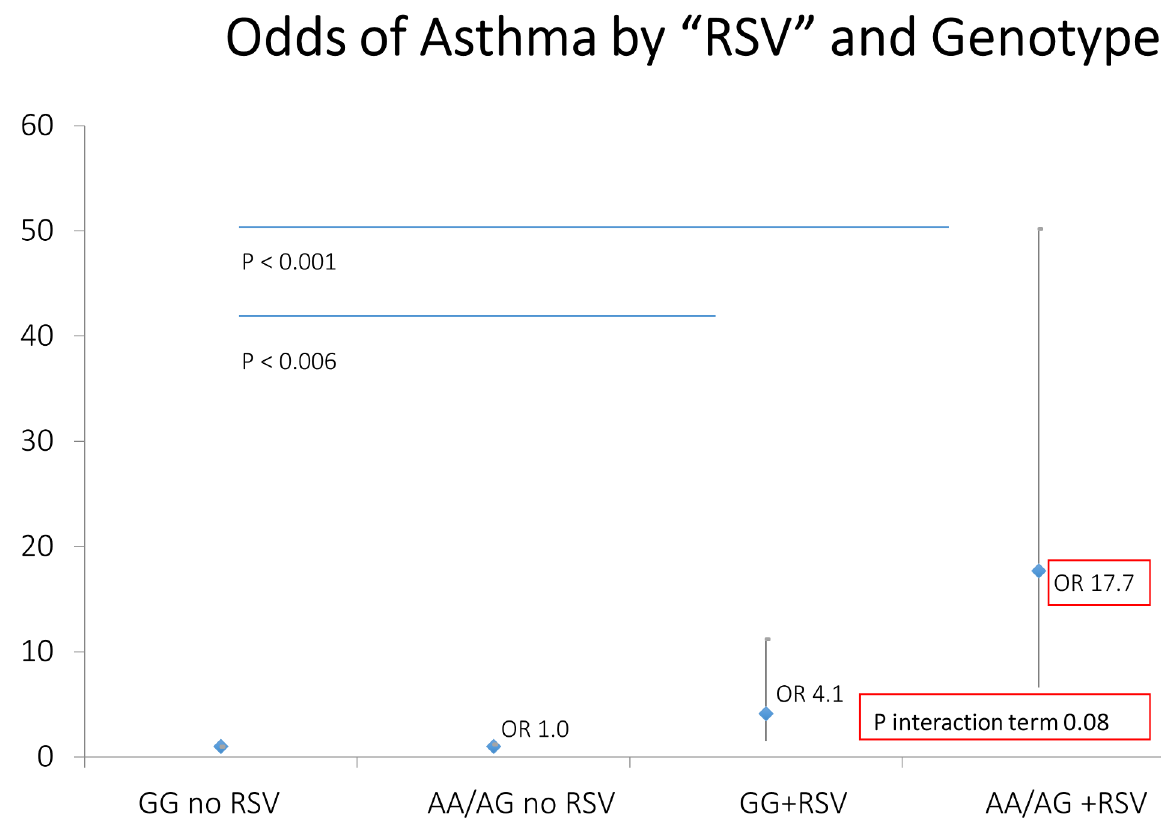
Fig 1. Joint association of bronchiolitis/ RSV and PAI-1 risk genotype ( rs2227631 ) with Asthma. RSV indicates subjects who were diagnosed with bronchiolitis or RSV before age 2 years old. Adjusted for age, sex, ethnicity, ancestry, socioeconomic factors, environmental factors (history of farm animal exposure and received antibiotics during first year), family history of asthma and recruitment site.